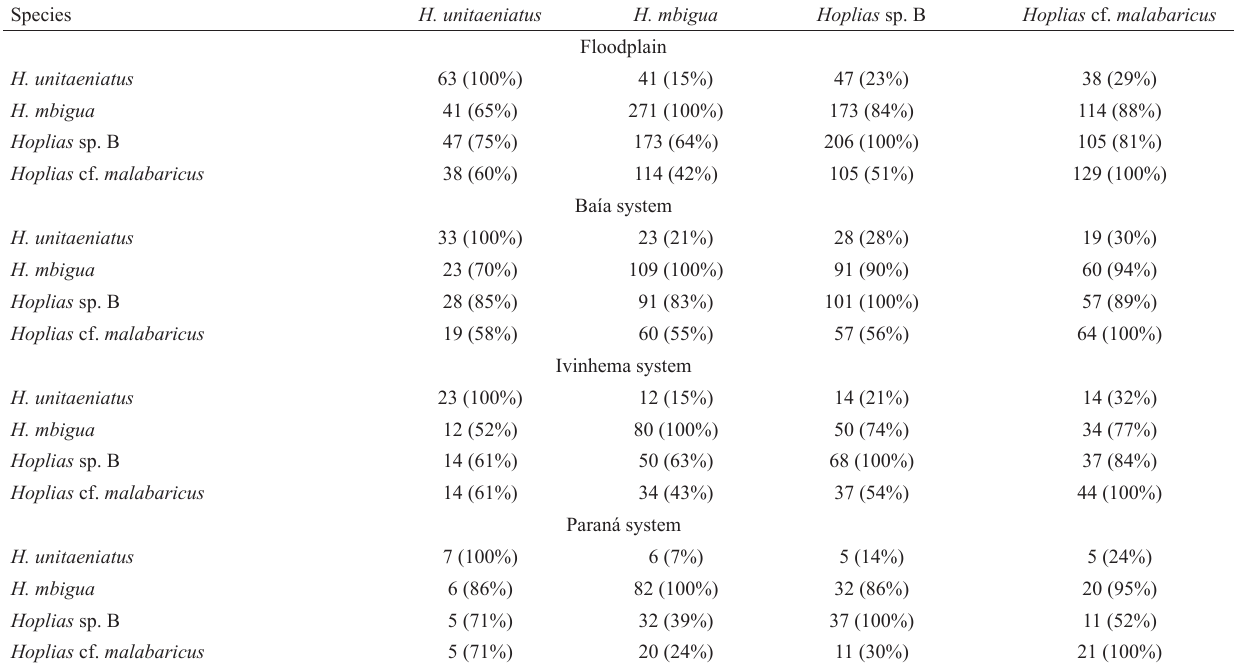
Tab. 3. Co-occurrence in terms of number and proportion (in parentheses) of each pair of Erythrinidae species in the upper Paraná River floodplain. Valid comparisons can be made only between the rows of a single